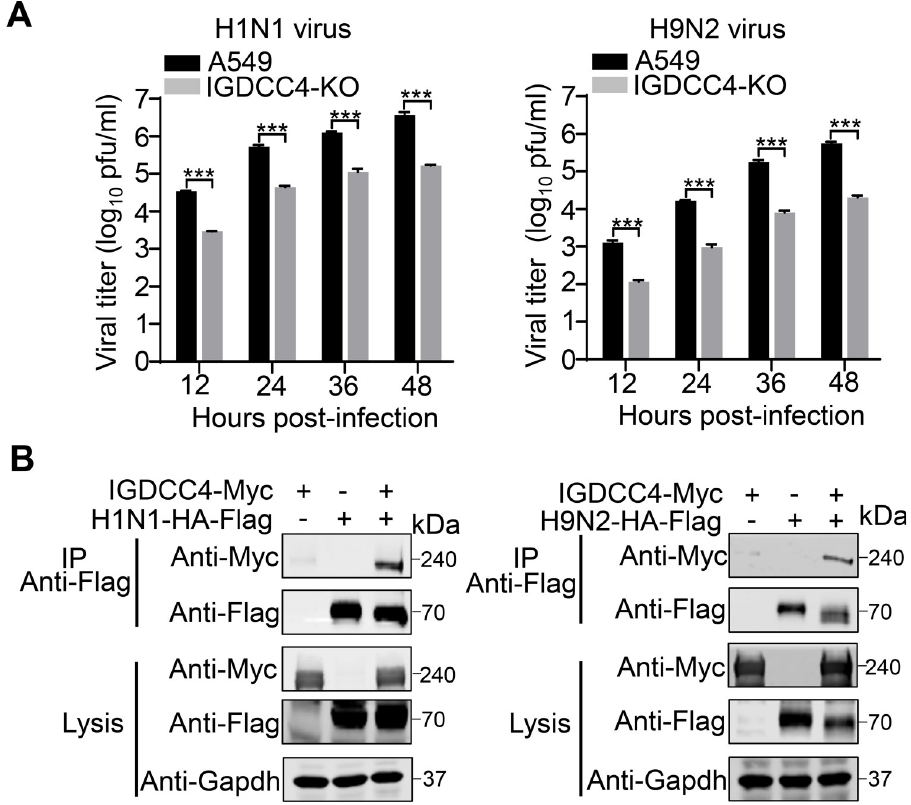
Fig 6. Effect of IGDCC4 on H1N1 influenza virus and H9N2 influenza virus. ( A ) Replication titers of H1N1 virus and H9N2 virus in A549 cells and IGDCC4-KO cells. A549 cells and IGDCC4-KO cells were infected with the indicated virus at an MOI of 0.01 and the supernatants were harvested at the indicated time for virus titration in MDCK cells. The data shown are from three biological replicates (means ± SDs) ( B ) Interaction of IGDCC4 with the HA protein of H1N1 virus and H9N2 virus. HEK293T cells were transfected individually or in combination with plasmids for the expression of IGDCC4 fused with Myc tag and viral HA protein fused with Flag tag. Cell lysates were immunoprecipitated with a mouse anti-Flag monoclonal antibody. The data shown are representative of three independent experiments. The two-tailed unpaired t -test was used for the statistical analysis. ��� , p < 0.001.